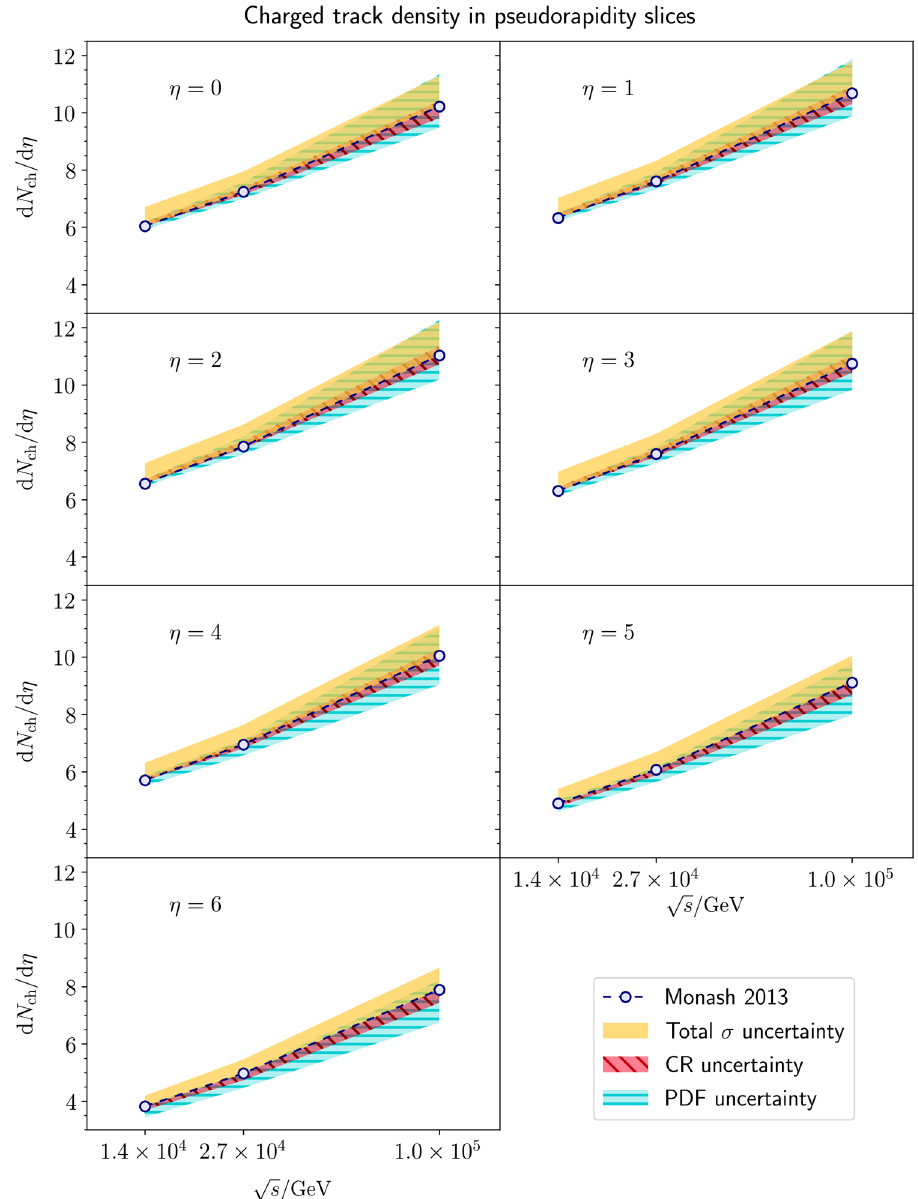
Fig. 8 Plots showing the scaling of the charged